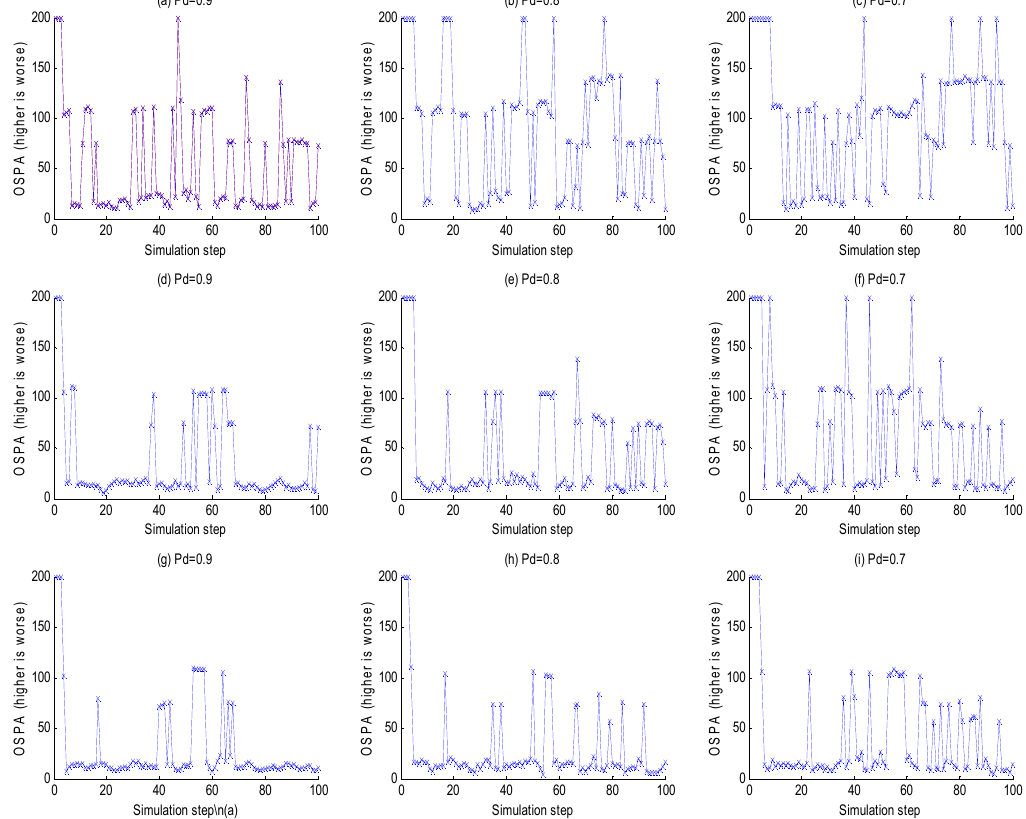
Figure 8. The OSPA of multisensor data fusion. ( a – c ) are the OSPA of GMPHD filter tracking results at different detection probabilities; ( d – f ) are the OSPA of two sensors global estimations by the MDC-MTF algorithm; ( g – i ) are the OSPA of three sensors global estimations by MDC-MTF algorithm.